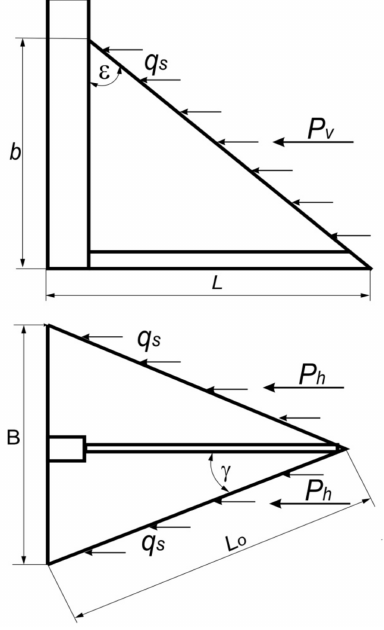
Figure 2. Scheme of forces acting on the tine for fallow